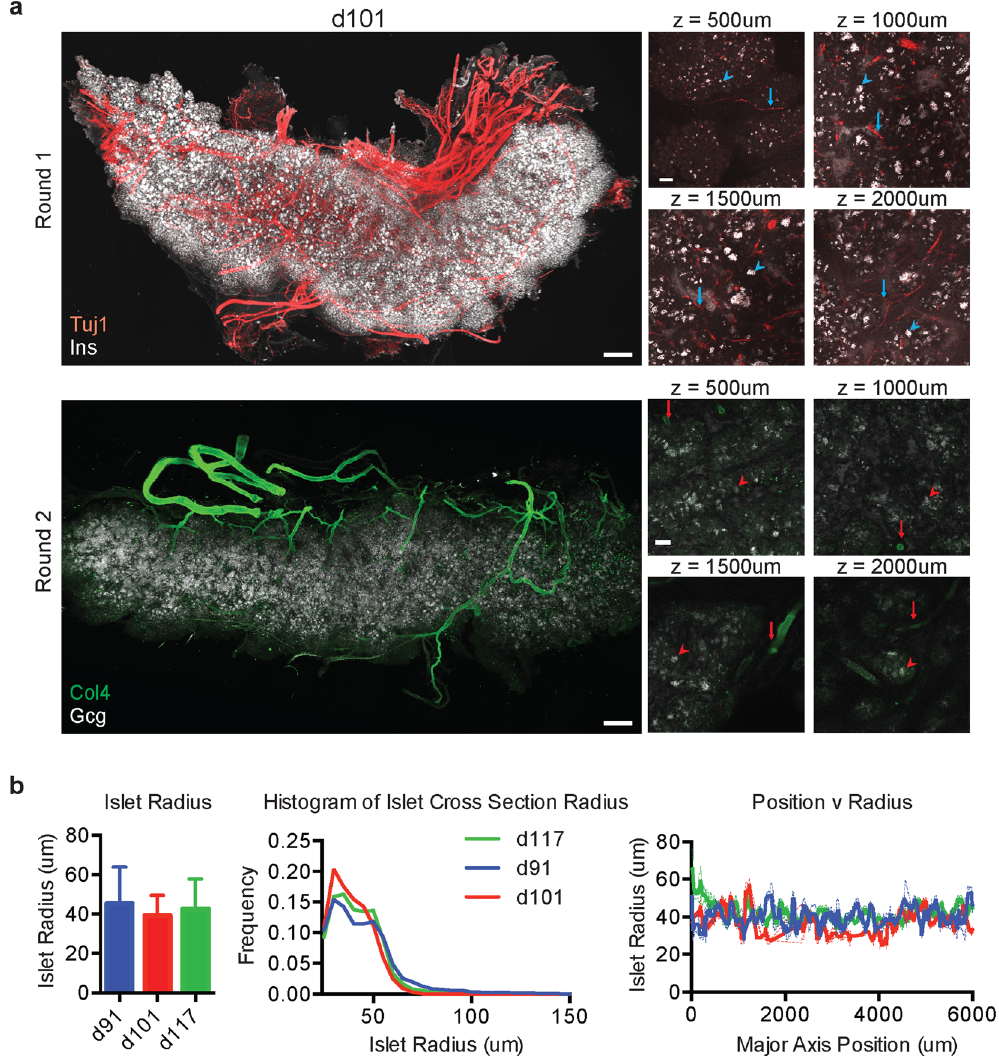
Figure 3. CLARITY for whole human organs. ( a ) CLARITY enables high-resolution and high-quality whole- organ tissue processing and analysis of human fetal tissues. A day 101 fetal sample (top row) can be stained, with Insulin (Ins) and β -tubulin (Tuj1), and imaged through several millimeters of cleared tissue without loss of resolution. Four example z positions spanning the entire pancreas thickness are shown with islets (arrowheads) and nerves/vessels (arrows) observed at each depth. The same tissue can be stained multiple times with different sets of antibodies – Type 4 Collagen (Col4) and Glucagon (Gcg) - (bottom row) with minimal loss of feature resolution. Scale bars = 500 μ m whole sample, 100 μ m inset. Samples were embedded in A1B1P4 hydrogel and cleared for 2–3 weeks at 60 °C. Antibody removal was performed by clearing for 5–7 days at 60 °C. ( b ) CLARITY enables automated quantification of structural features, including islet size. In this cohort, there was no significant difference (unpaired t-test) in average islet size, population distributions, or spatial distributions of islet sizes at different developmental ages between d91 and d117. Error: s.e.m. n =